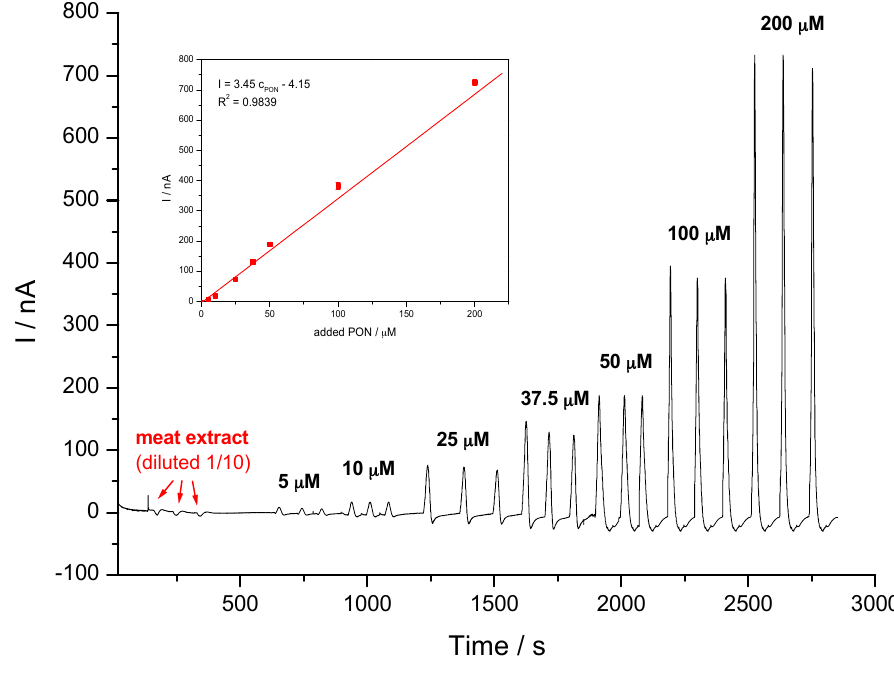
Figure 10. FIA amperogram for PON added in meat extract (diluted 1/10 with PBS pH 9.0). Inside: calibration graph for PON in meat extract. E = +75 mV; flow rate = 0.38 mL · min − 1